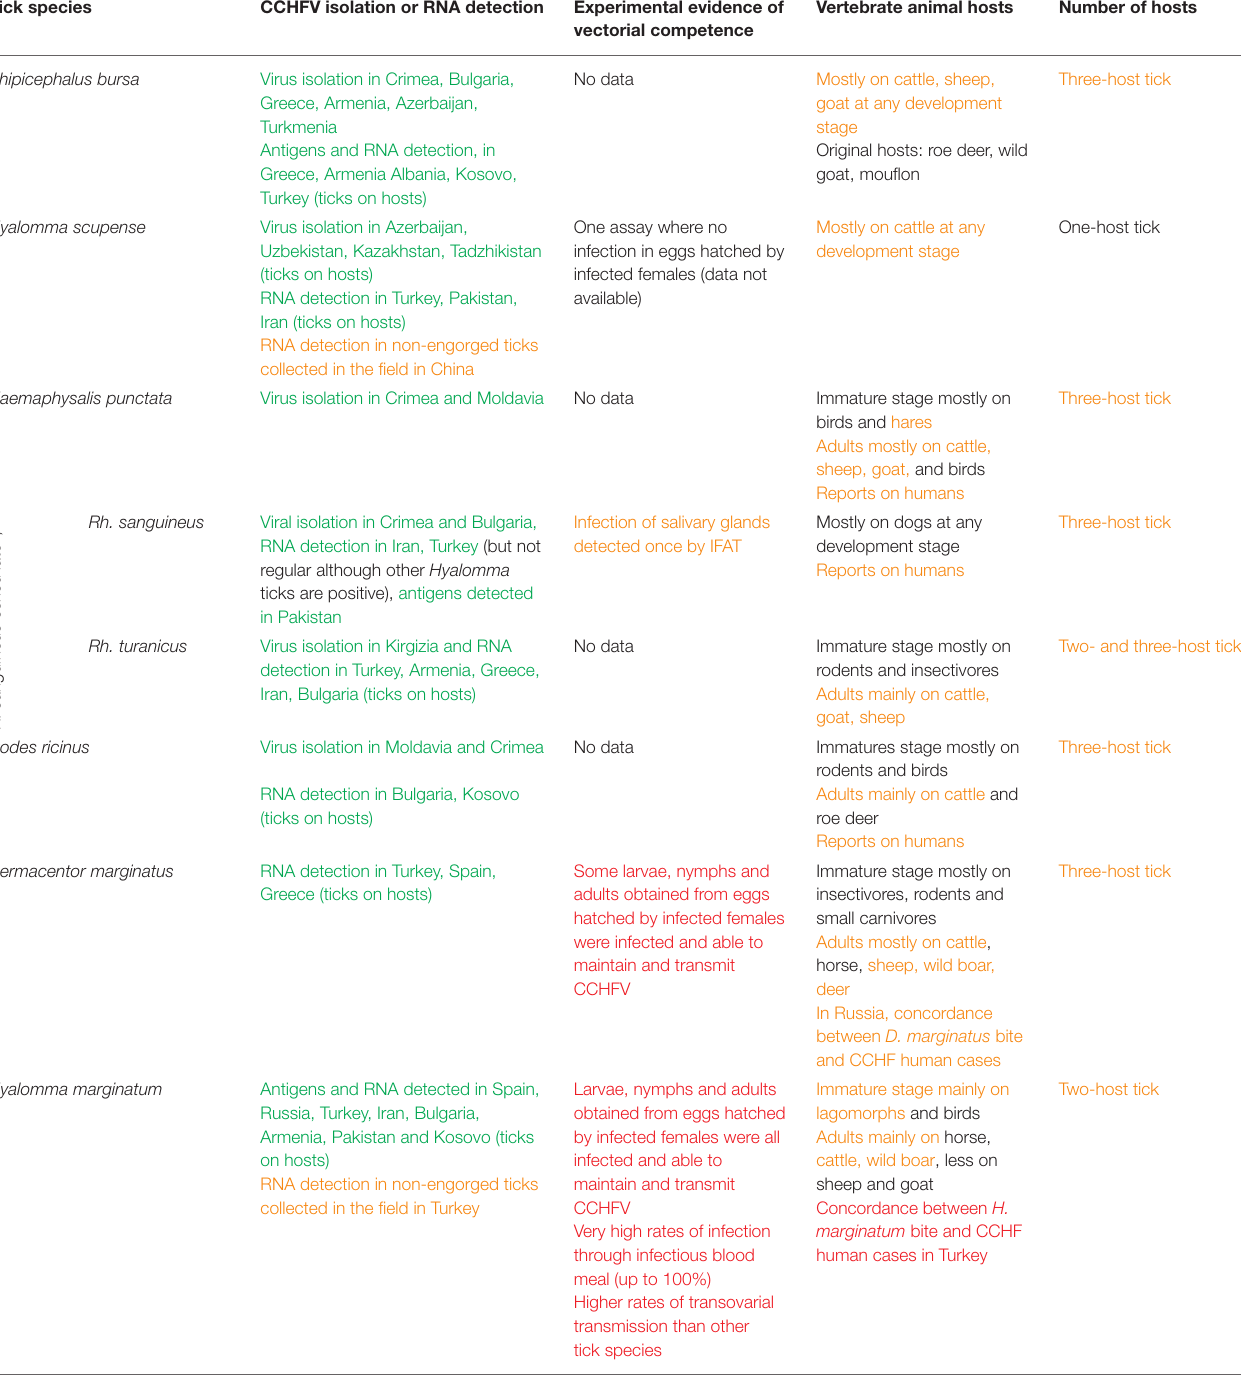
TABLE 1 | Candidate tick species as vectors and/or reservoirs of CCHFV in France. Tick